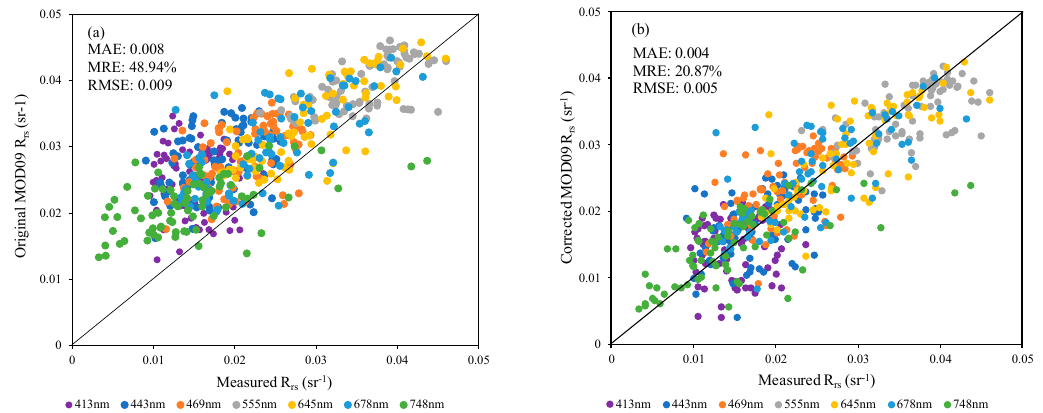
Figure 8. Scatterplots of R rs derived from ( a ) original and ( b ) corrected MOD09 compared with measurements in different bands. Table 5. Error statistics of R rs derived from the original MOD09.